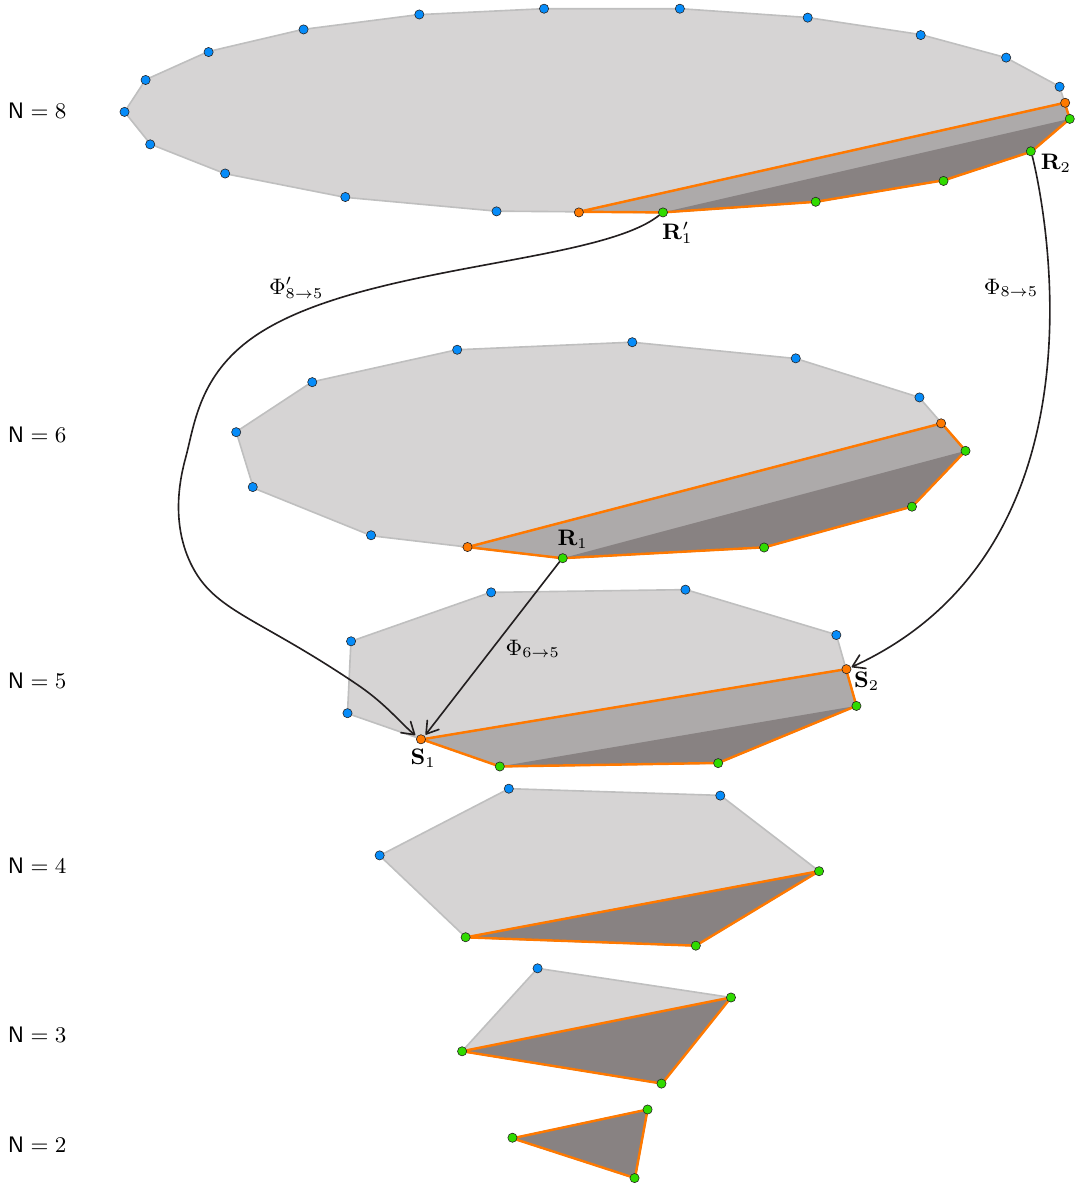
Figure 15. A schematic cartoon of a cross-section of the SAC N and the HEC N for different values of N . The extreme rays of the SAC N are represented by the green and blue vertices. The green ones are also extreme rays of the HEC N , and their conical hull is the darkest shaded region. The blue ones are outside of the HEC N . The boundary of the HEC N is highlighted in orange, and the orange vertices represent extreme rays of the HEC N which are not extreme rays of the SAC N . The arrows indicate color-projections associated with coarse-grainings that implement the reconstruction, mapping the green vertices to the orange. For N = 5 the figure shows two extreme rays S 1 and S 2 that are not extreme rays of the SAC 5 and need to be reconstructed. While N = 6 is sufficient to obtain S 1 as S 1 = Φ 6 → 5 R 1 , it is not sufficient to reconstruct S 2 . On the other hand, N = 8 is sufficient to reconstruct both rays, S 1 = Φ 0 R 0 and S 2 = Φ 8 → 5 R 2 . To avoid clutter, we are suppressing all 8 → 5 1 irrelevant projections/lifts of other extreme rays. The shapes of the cone cross-sections (as well as the numbers of facets and extreme rays of various kinds) are not meant to be taken